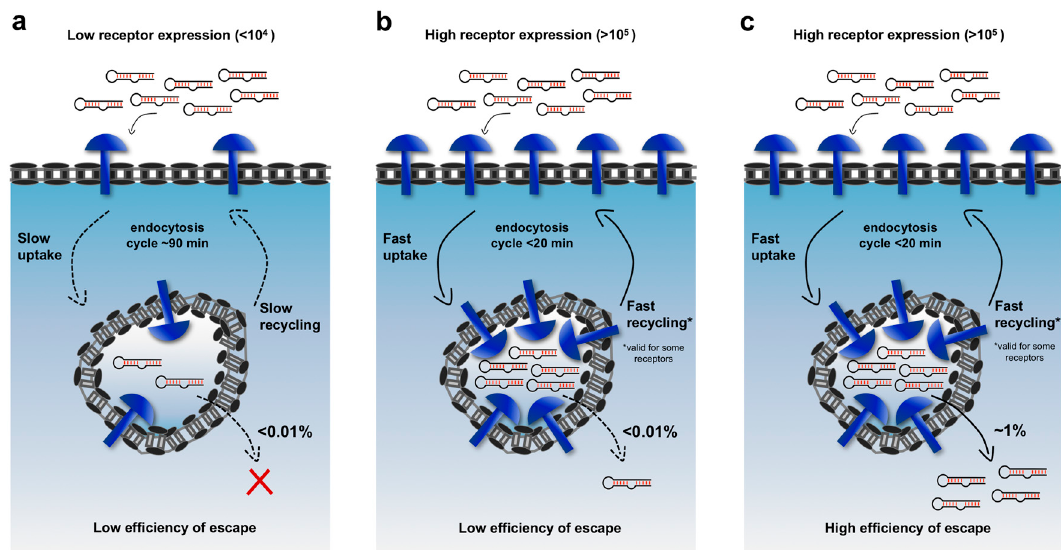
Figure 1. Relationships among three key factors that govern cytosolic delivery: receptor expression on the cell surface, rate of endocytosis and endosomal escape efficiency of cargoes. In ( a ) and ( b ) the estimated efficiency of escape is <0.01% per cycle of endocytosis; ( a ) Upon binding to low-expressed receptors (<10 4 copies/cell) that internalize with slow rate of uptake (~90 min), a negligible cytoplasmic translocation of internalized aptamers occurs; ( b ) Increased translocation can be observed when cell targeting aptamers bind highly expressed receptors (>10 5 copies/cell) that show faster internalization (~20 min). This situation can, in some extent, resemble some successful cancer therapy strategies aim to target asialoglycoprotein receptor (ASGPR), which is expressed at high levels on the surface of liver cells ( c ) An ideal delivery system should bind highly expressed receptors (>10 5 ) with high rate of uptake (~20 min) and should possess an enhanced endosomal escape efficiency (i.e., high efficiency of cargoes ~1%/cycle).